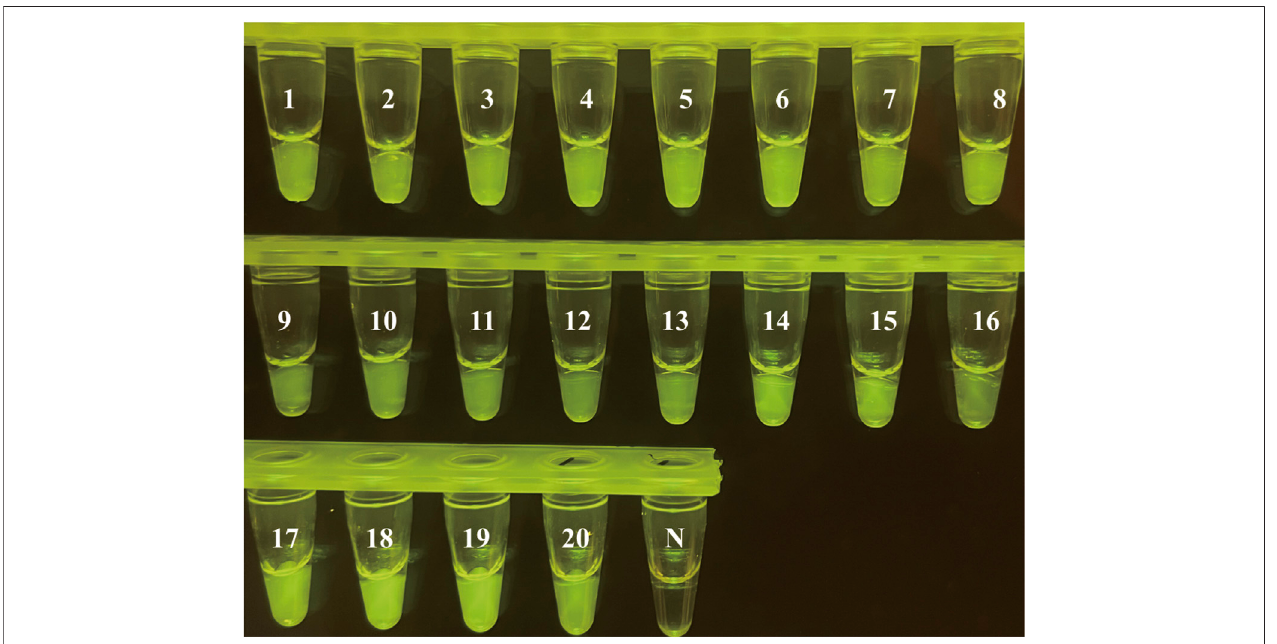
FIGURE 6 | S. fl exneri isolate evaluation using CRISPR/Cas12a-E-LAMP. Twenty S. fl exneri strains were used in the clinical evaluation of CRISPR/Cas12a-E-